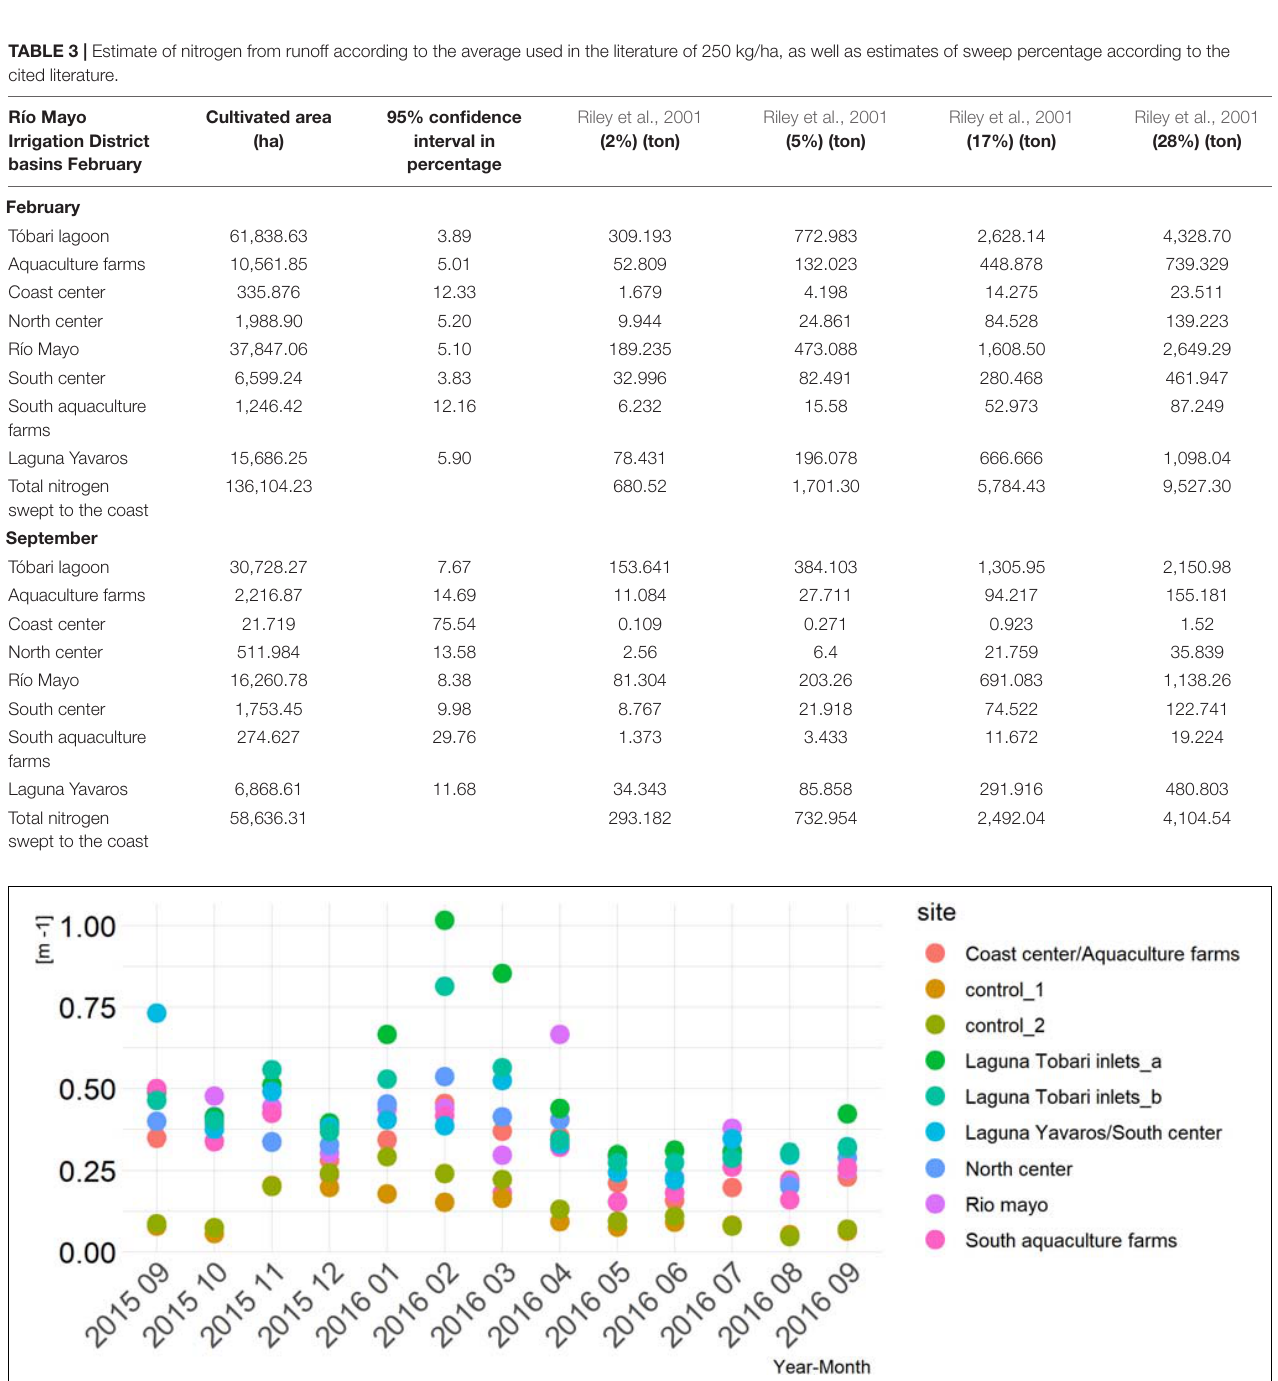
FIGURE 5 | K d (490) values for each of the entry points of nutrients to the coastal zone by month for the two agricultural